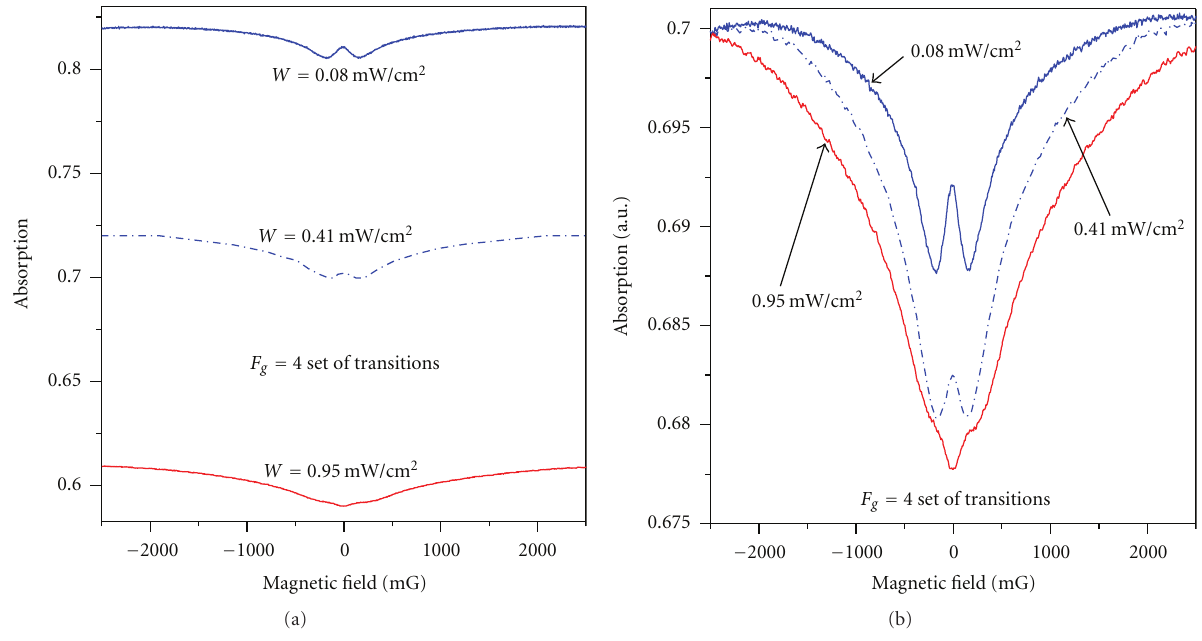
Figure 4: CPT bright resonance sign reversal with laser power density observed on the D 2 line of Cs at the F g = 4 set of hyperfine transitions. Thin cell with L = 700 μ m and T = 34 ◦ C; CPT resonance profile (a) presented in absolute absorption scale; (b) zoomed-in arbitrary absorption